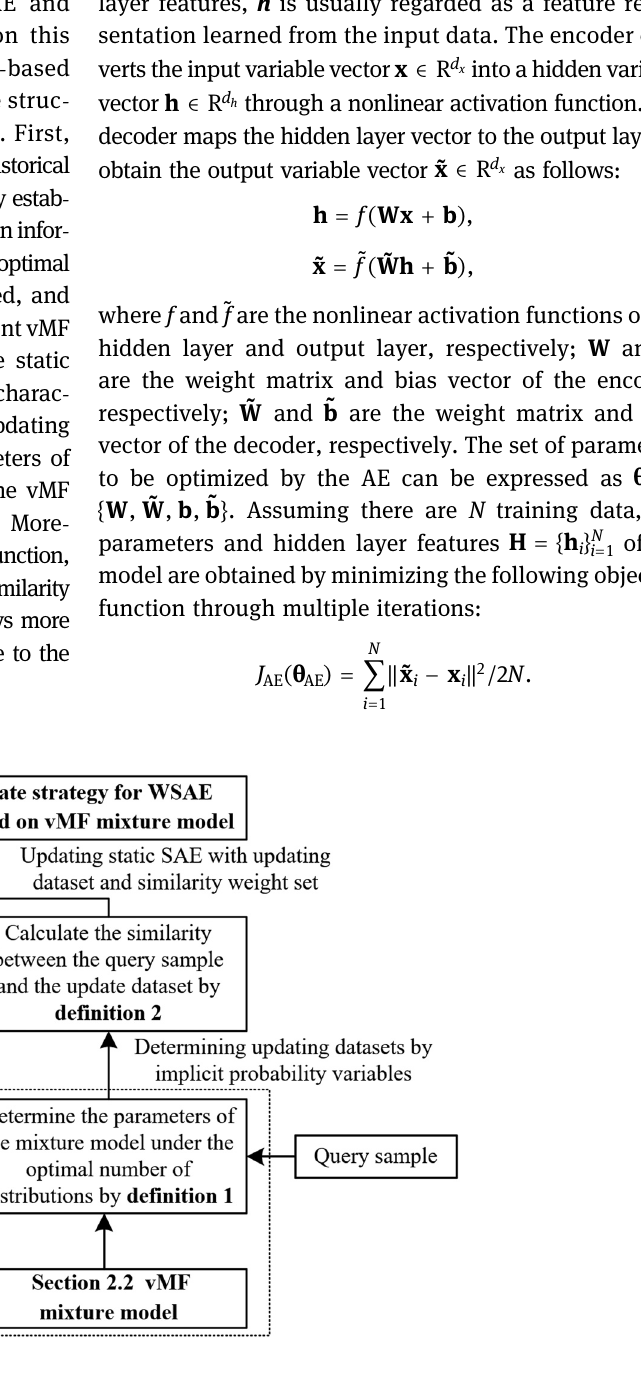
Figure 2: The structure of the proposed